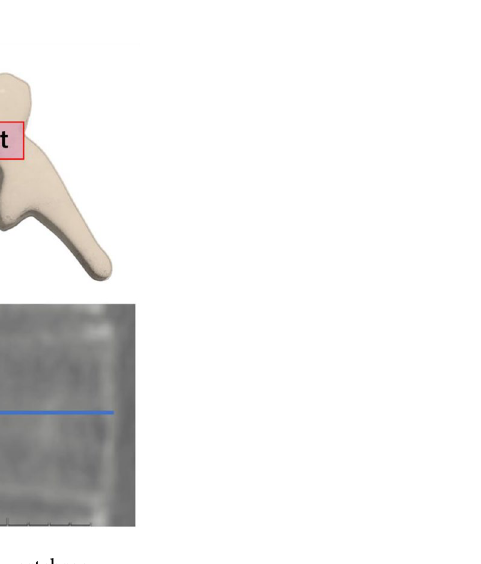
Figure 6. Measurement location of the thoracic